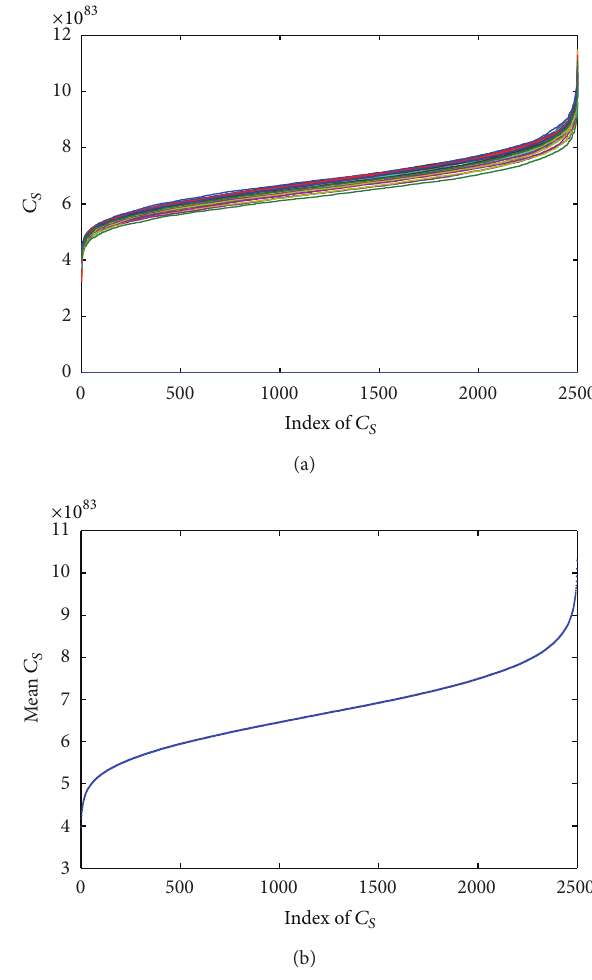
Figure 1: (a) The subgraph centrality 𝐶 𝑆 (𝑖) curves of the ER model, (b) mean subgraph centrality ⟨𝐶 𝑆 (𝑖)⟩ curve of the ER model.